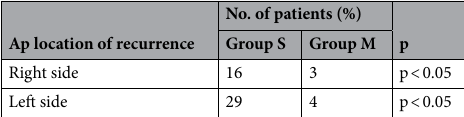
Table 3. Characteristics of